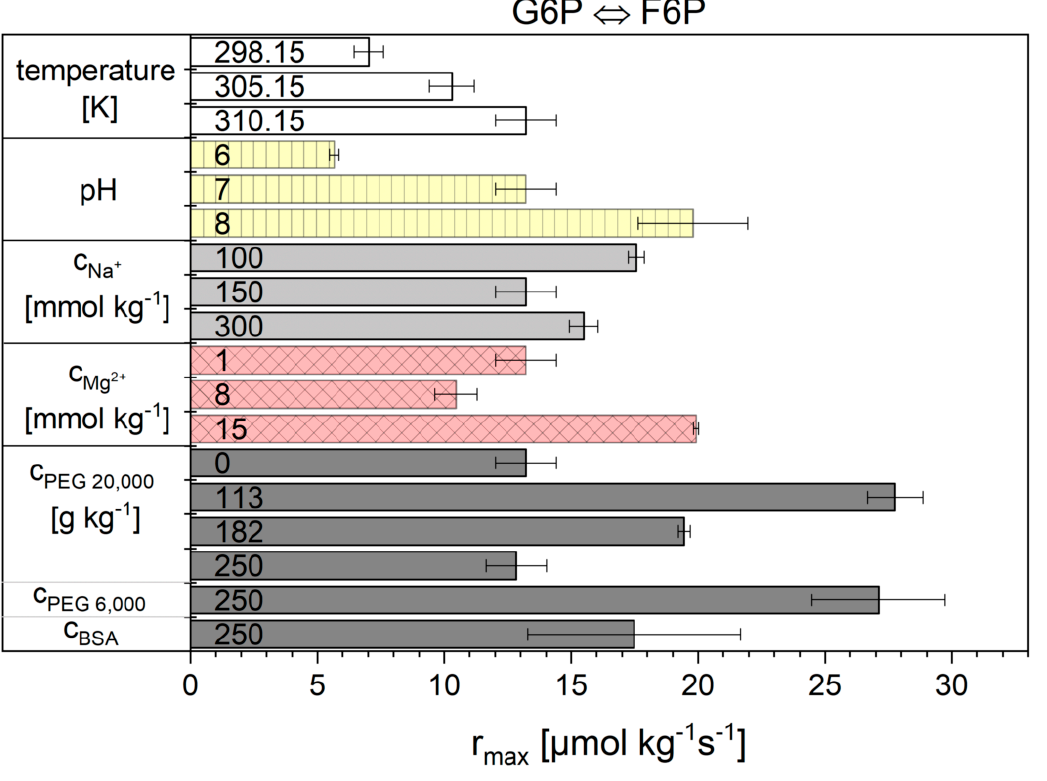
Figure 2. r max values obtained for reaction 2 from the Noor model. The error bar results from the standard deviation of the triple determination of each measurement condition.